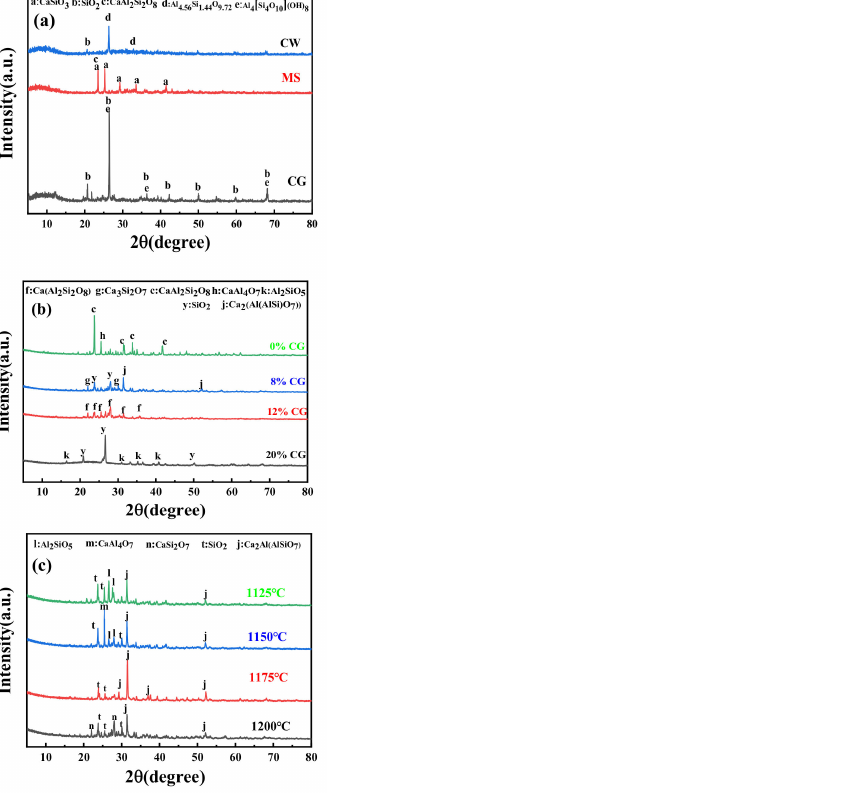
Figure 2. XRD pattern of samples: ( a ) raw materials; ( b ) mixing binder with different CG con- tent sintered at 1200 ◦ C; and ( c ) samples under different sintering temperatures with 8% CG in mixing binder.